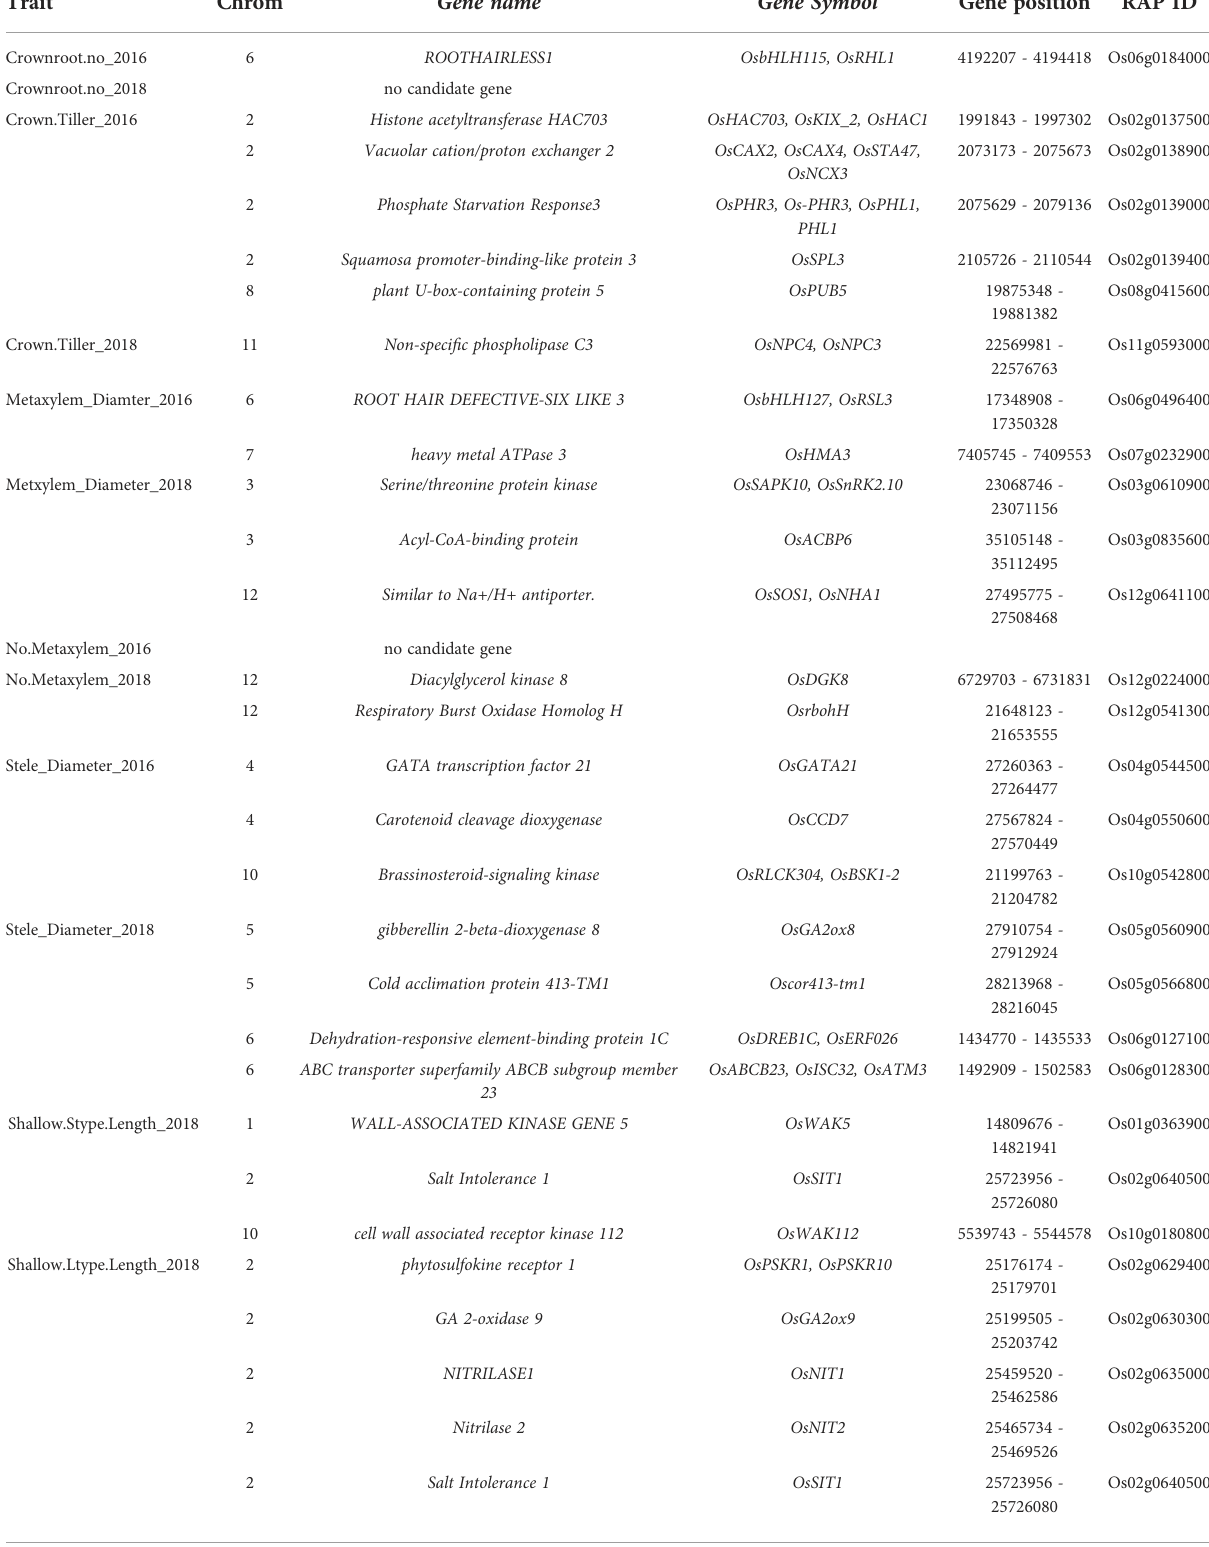
TABLE 2 Candidate genes containing functional SNPs from the GWAS analysis on root phenotypes of the Thai/Southeast Asian